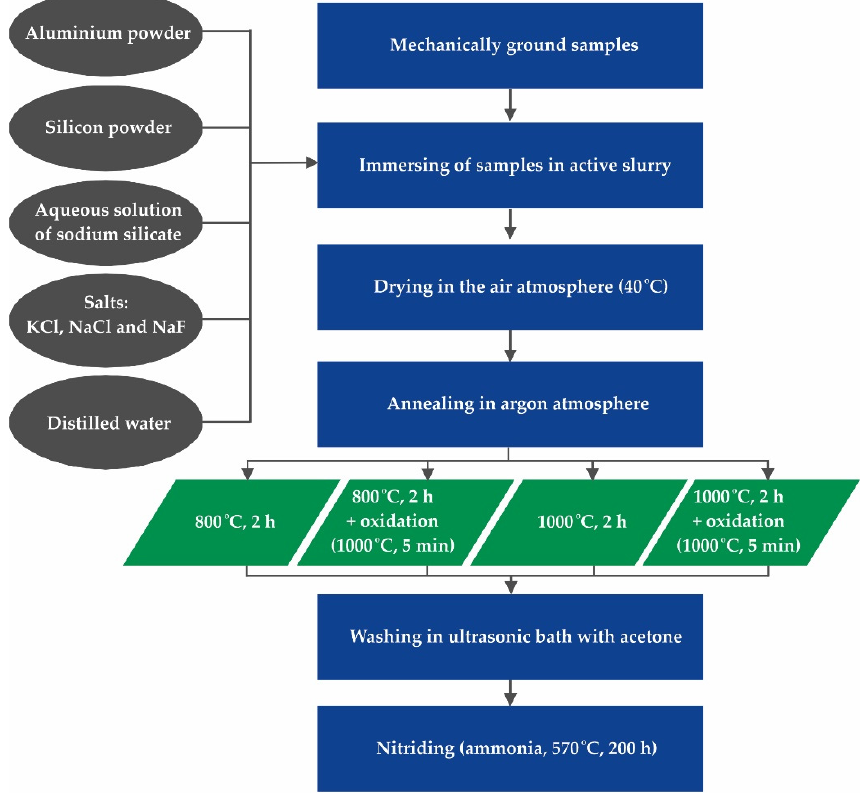
Figure 1. Scheme of the experimental protocol.